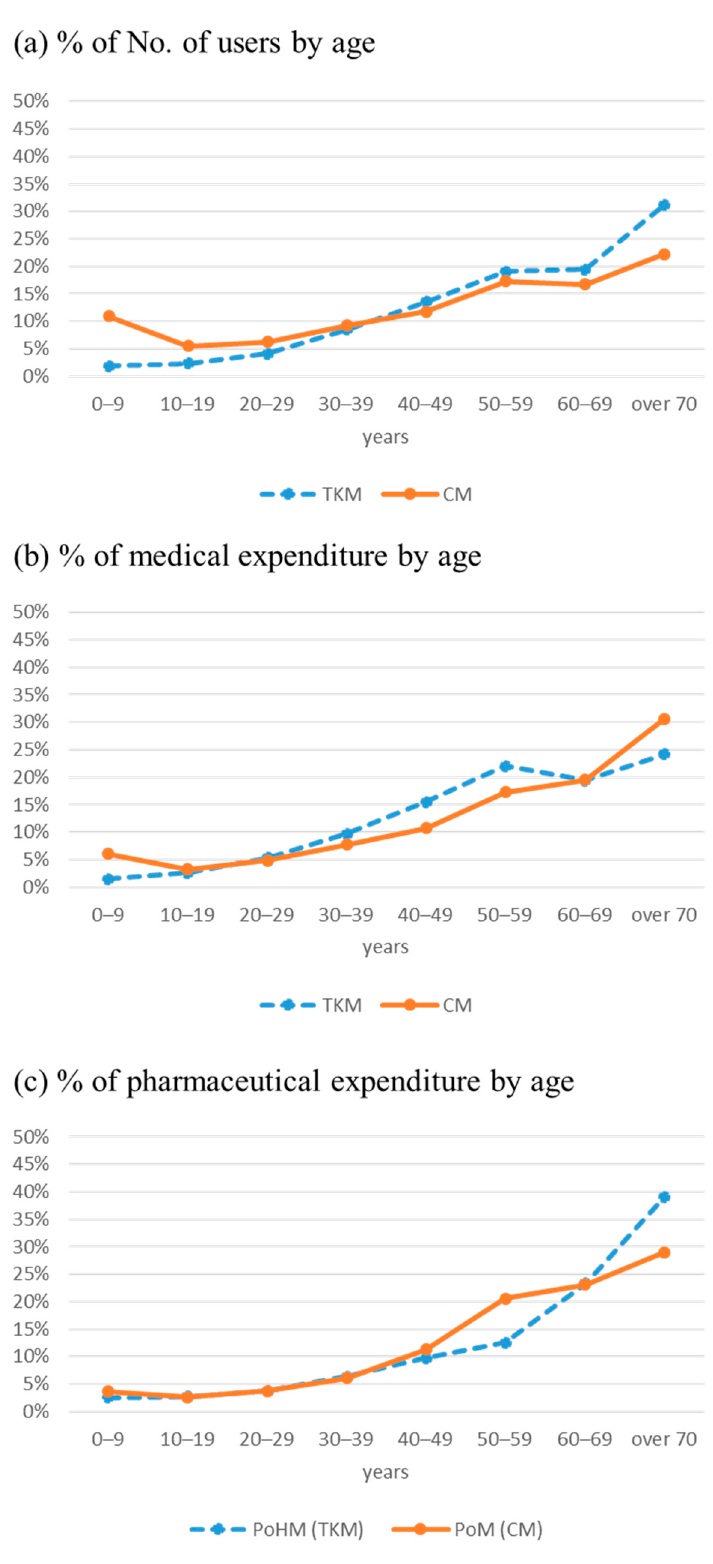
Figure 1. % of the number of users (( a ), top ), % of medical expenditure (( b ), middle ), and % of pharmaceutical expenditure (( c ), bottom ) in Conventional medicine (solid line) and Traditional Korean Medicine (dotted line) by age in the National health insurance in 2017. Abbreviations: CM, Conventional medicine; TKM, Traditional Korean Medicine; PoM, Prescription only Medicines; PoHM, Prescription only Herbal Medicines.